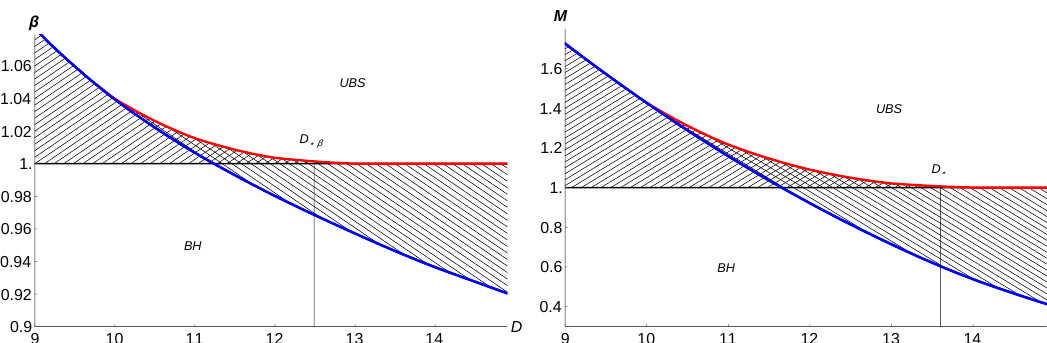
Figure 1 . Range of existence (hatched) of non-uniform black strings in a compact circle of (cid:12)xed length, as a function of the spacetime dimension D and the inverse temperature (cid:12) or the mass M (results obtained numerically at 4NLO). The vertical axes are normalized relative to the value for a uniform black string at the threshold of the GL instability, so the lines (cid:12) ; M = 1 separate UBS into stable above the line, and unstable below the line. D (cid:3) ’ 13 : 6 is Sorkin’s critical dimension [11], which separates the dimensions in which weak non-uniformity makes M increase ( D < D (cid:3) ) or decrease ( D > D (cid:3) ). D (cid:3) (cid:12) ’ 12 : 5 plays a similar role for (cid:12) . The blue curve marks NUBS that reach zero tension, as a proxy to the transition to localized black holes (BH). The red curve indicates local maxima of (cid:12) or M , reached as the non-uniformity increases when 9 . D < D (cid:3) (cid:12) ; D (cid:3) . The doubly-hatched region is a fold in phase space, where two NUBS phases coexist with the same (cid:12) or the same M , but di(cid:11)er in their entropies. For D . 10, NUBS branches terminate before any local maximum of (cid:12) or M is reached. BH phases (not studied in this paper) coexist and can dominate thermodynamically over NUBS in regions of (cid:12) ; M > 1 at low D . The blue curves behave asymptotically at large D like (cid:12) (cid:24) D (cid:0) 1 = 4 and M (cid:24) D (cid:0) D= 4